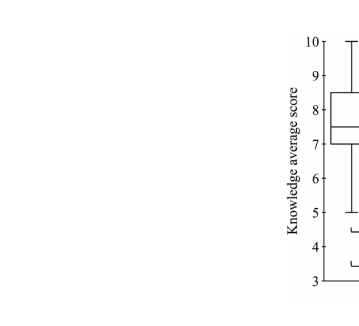
FIGURE 2 | Average scores of sustainability variables (knowledge, attitude, awareness) in time (T 0 , T 1 , T 2 ). Brackets with asterisks indicate signi fi cant differences between two groups: *** (p < 0.001). The box indicates the 25 th and 75 th percentiles, the line within the box marks the median, and the cross is the average. Whisker length is equal to 1.5 × interquartile range. N = 194.